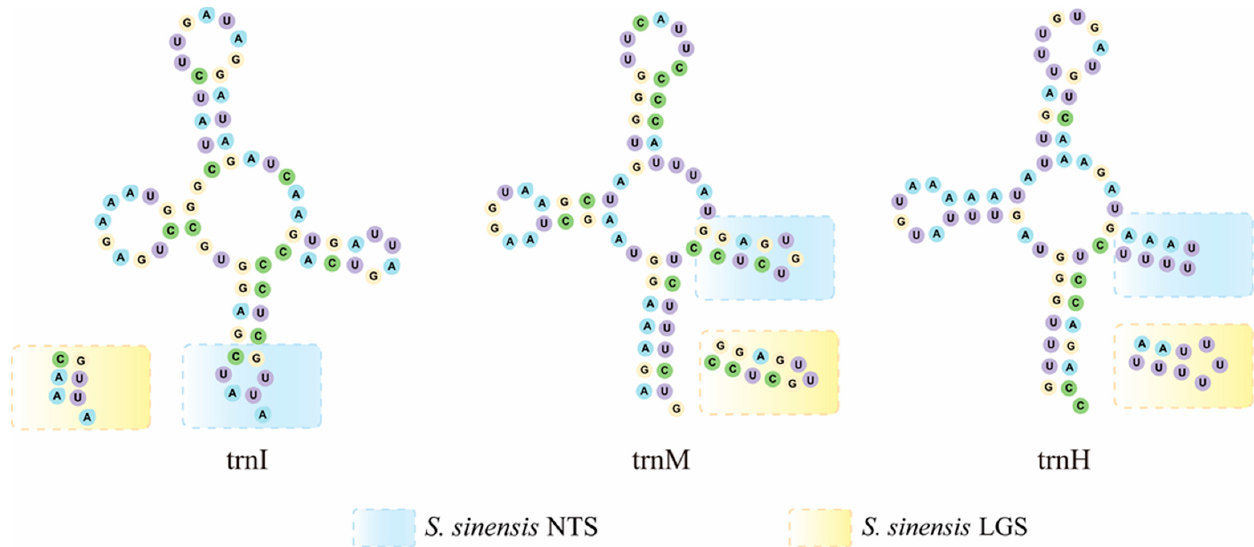
Figure 4. The secondary structures of the tRNA genes in S. chinensis NTS and S. chinensis LGS are shown with differences between the two species highlighted with boxes of different colors: S. chinensis NTS in blue and S. chinensis NTS in yellow.